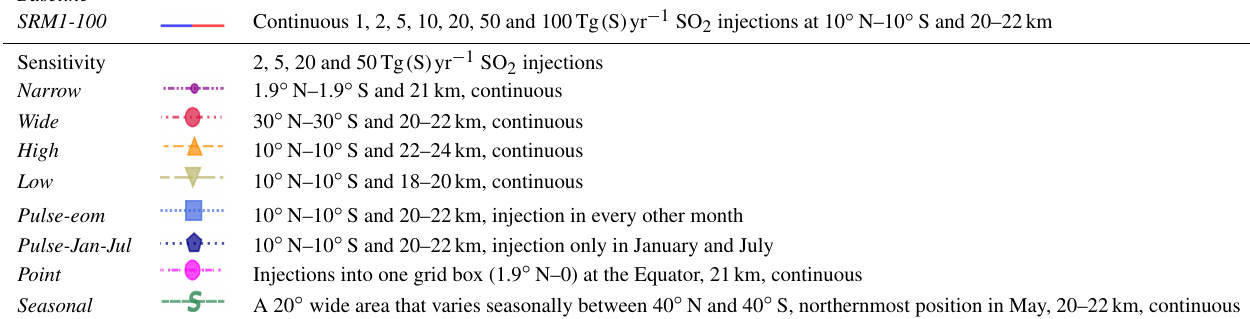
Table 1. The simulated scenarios, where the line styles and markers used to indicate the scenarios in the figures are shown beside the corresponding scenario name. SALSA Baseline results are shown using blueish colours, and M7 results are shown using reddish colours in Sect. 3.1 and black in Sect. 3.3. Injections are done across all longitudes between the stated latitudes in all scenarios other than the Point